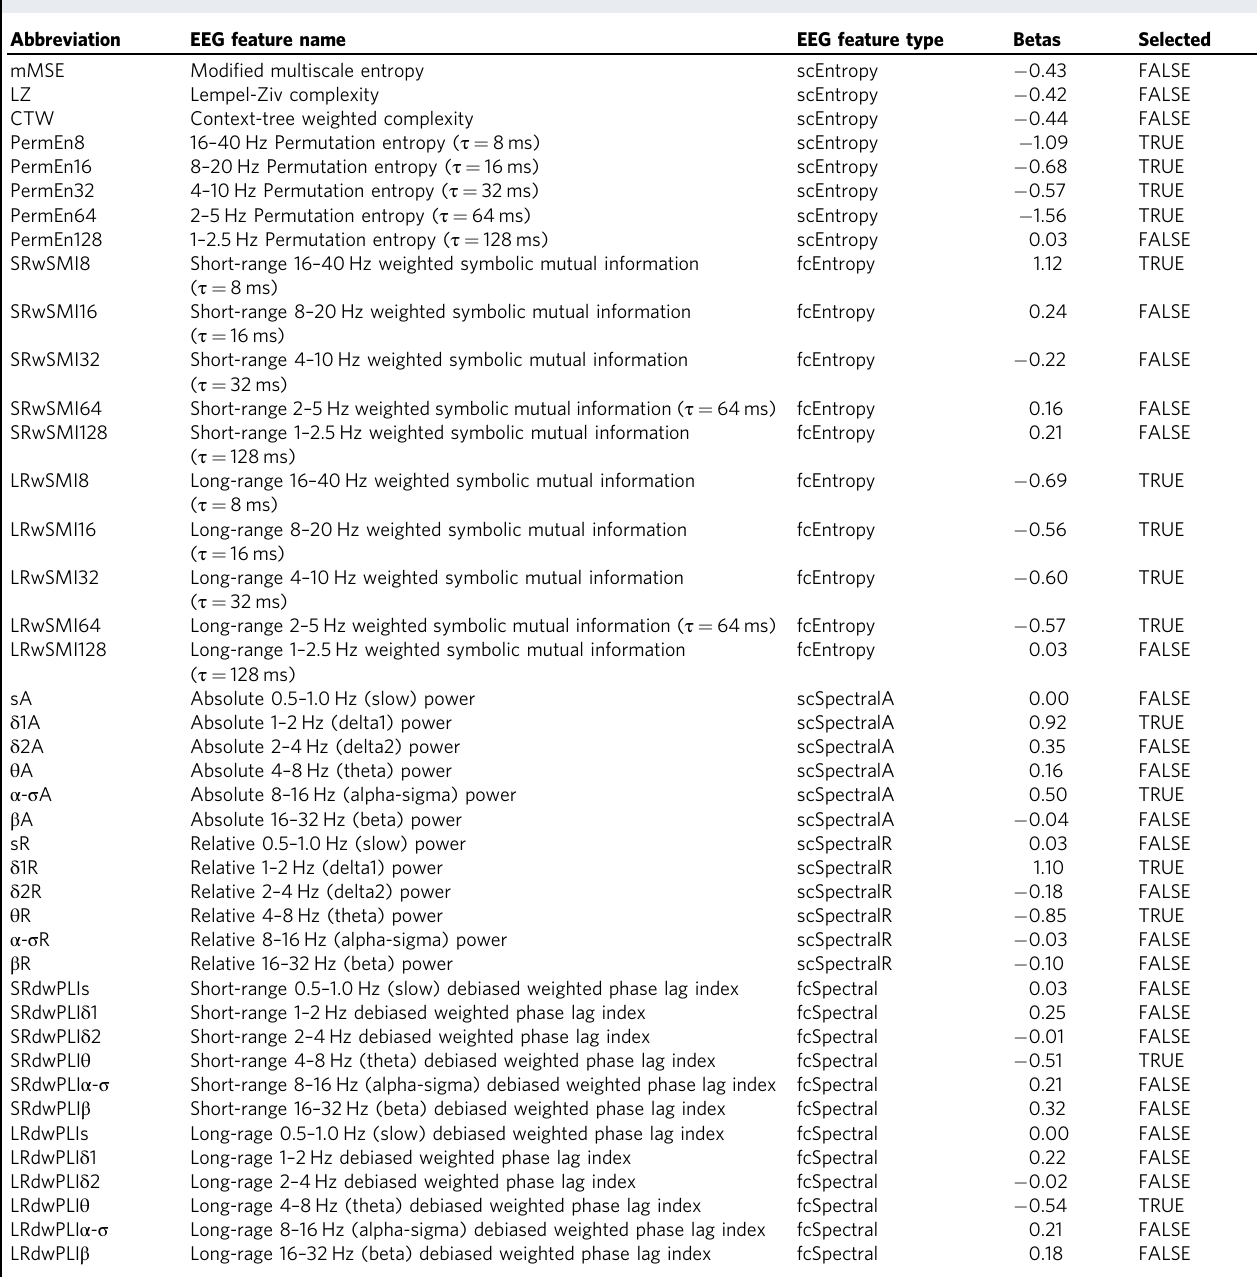
Table 2 Abbreviations for EEG features.